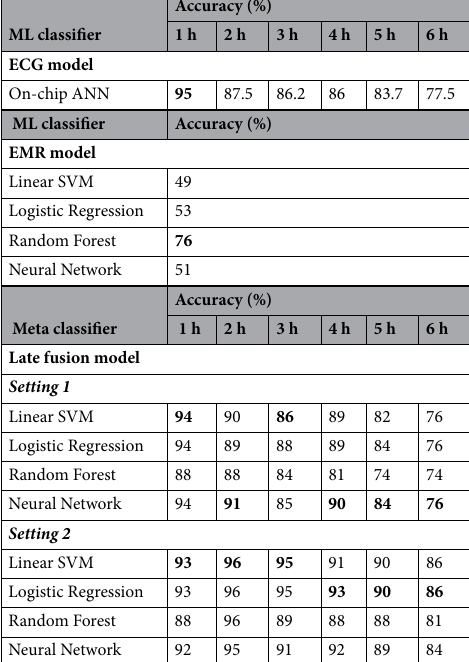
Table 1. Baseline prediction results using ECG on-chip model, and demographics and co-morbidity data. Late fusion model performance—Setting 1: using demographic and ECG data; Setting 2: using demographic, co-morbidity and ECG data. Optimal performance for every prediction task is highlighted in bold .